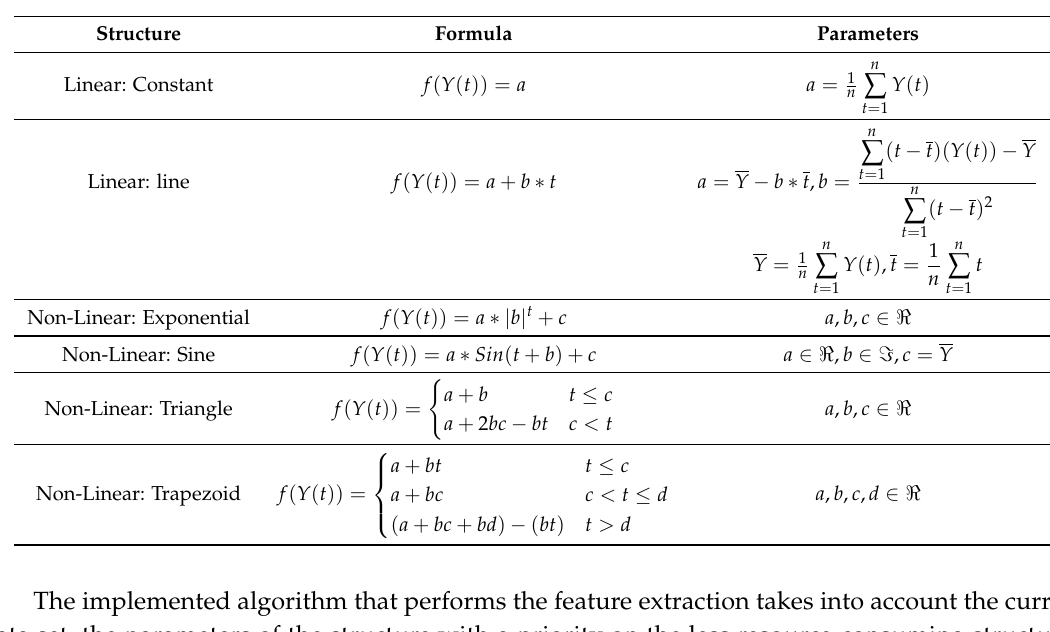
Table 2. Attribute counting: value and